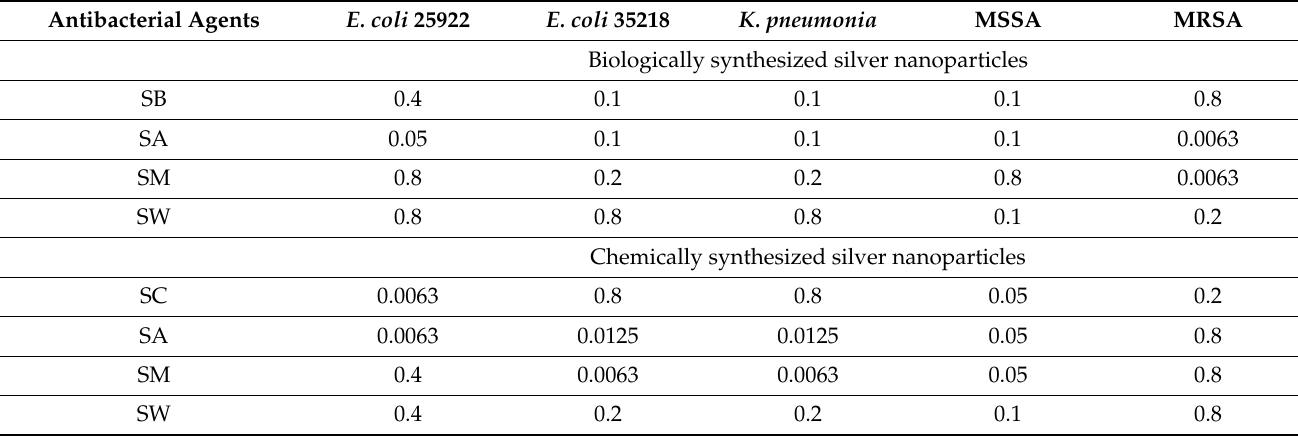
Table 1. Minimum inhibitory concentration (MIC) of biologically and chemically synthesized silver nanoparticles, as well as their conjugates with P. grandiflora extracts.